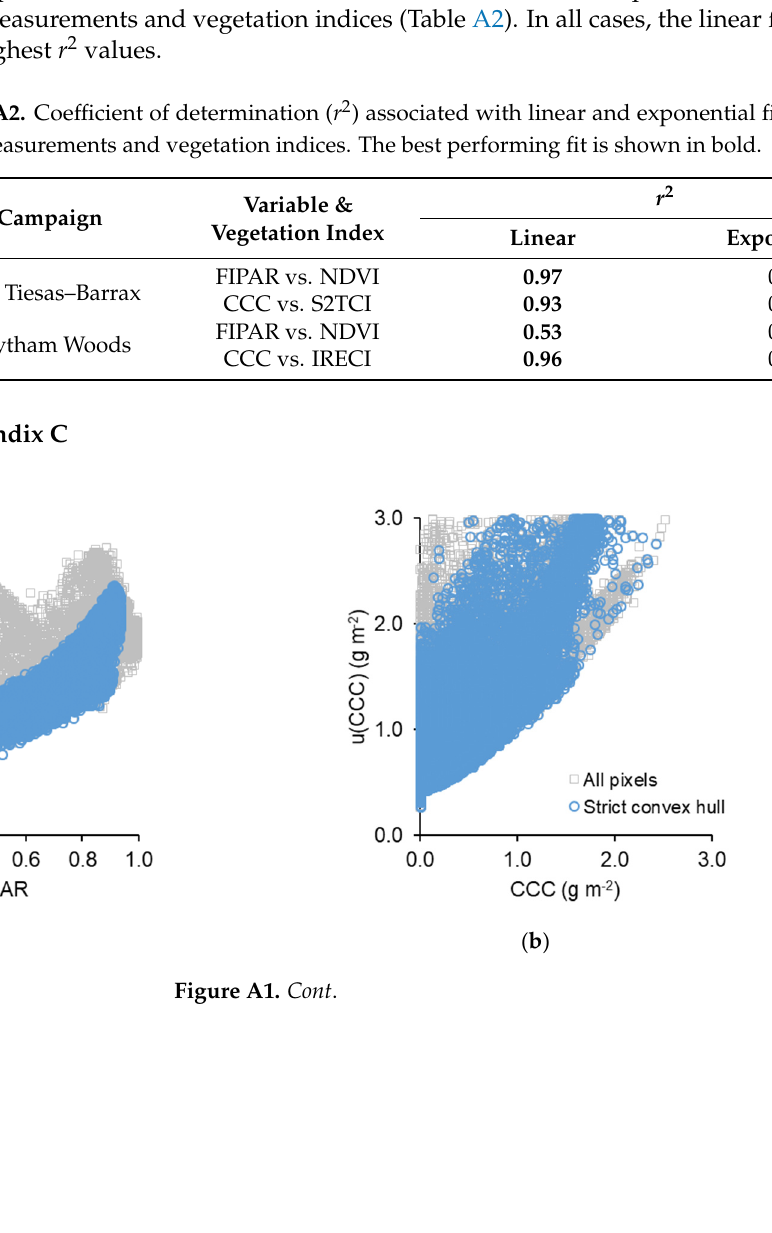
( d ) Figure A1. Comparison between pixel values and associated uncertainties for the high-spatial-resolution reference maps of FIPAR ( left ) and CCC (right ) at Las Tiesas–Barrax ( a , b ) and Wytham Woods ( c , d ). The coloured points represent pixels lying within the multispectral convex hull of the sampled ESUs (i.e., where the transfer function is not extrapolating). Appendix D